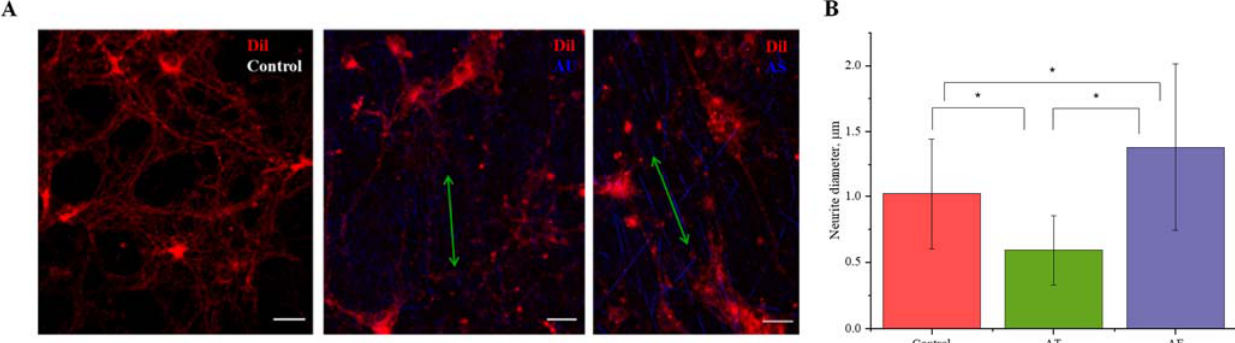
Figure 5. Measurement of neurite diameter using confocal microscopy. ( A ) Confocal image staining of neuronal cell membranes (Dil dye, red). Scale bar—20 μ m; ( B ) mean diameter of neurites cultivated on different substrates. * Statistically significant difference, p < 0.05.